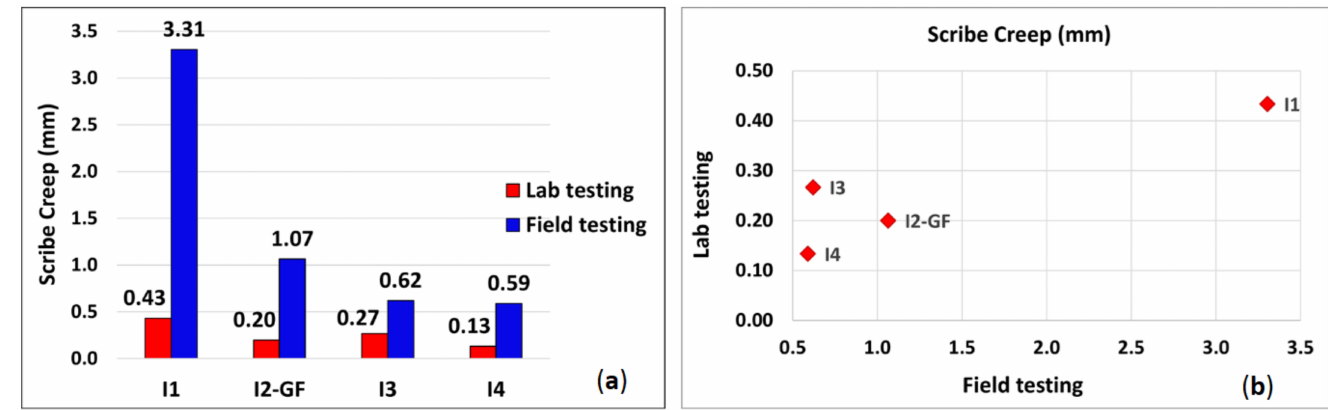
Figure 10. ( a ) Scribe creep of the submerged zone coating systems after accelerated aging and field testing. ( b ) Scribe creep after accelerated aging plotted as a function of scribe creep after field